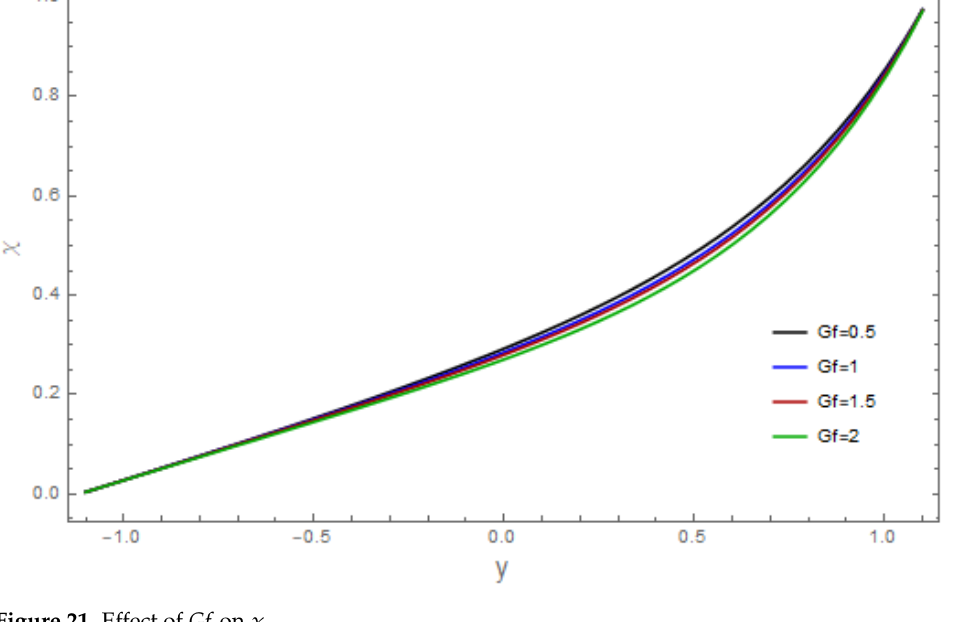
Figure 21. Effect of 𝐺𝑓 on 𝜒 .